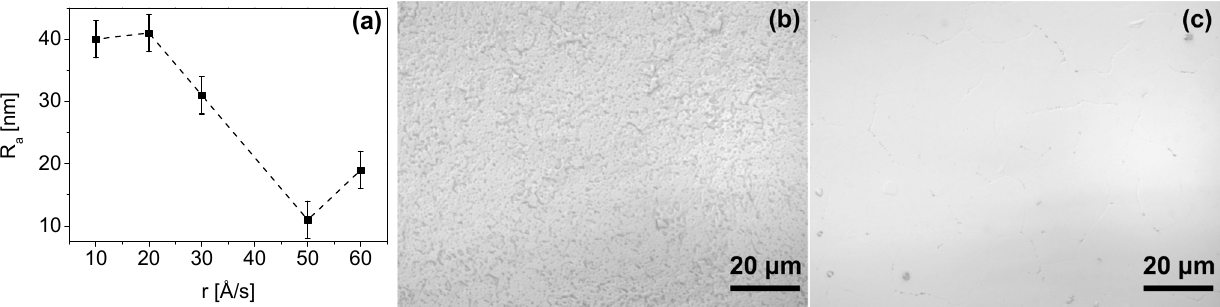
Figure 3. ( a ) Dependence of the roughness R a of the 8 μ m-thick In layer as a function of its deposition rate; ( b ) image of the surface of the In layer with roughness R a = 40 nm; ( c ) image of the surface of the In layer with roughness R a = 11 nm.